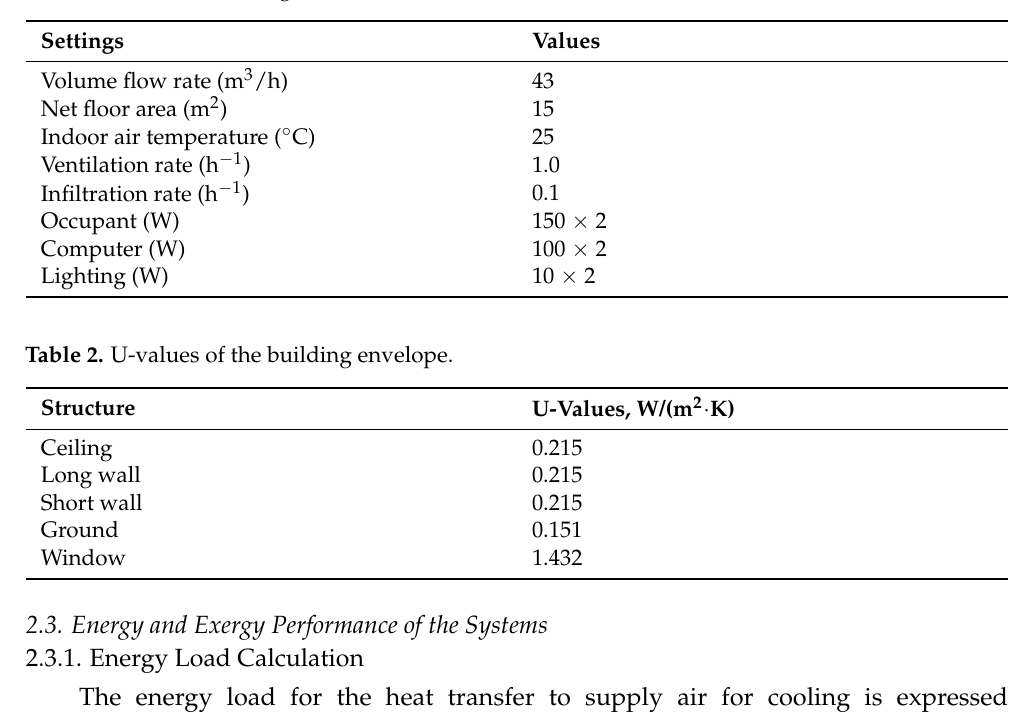
Table 1. Simulation setting in the office room.